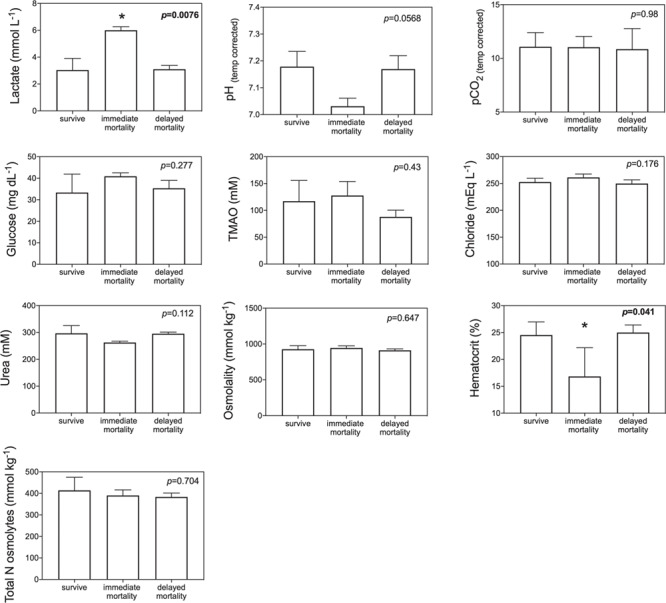
Bar plots comparing blood chemistry parameters among survivors, mortalities and delayed mortalities; Kruskal–Wallis nonparametric tests were performed, with significant P values in bold and indicated with asterisks